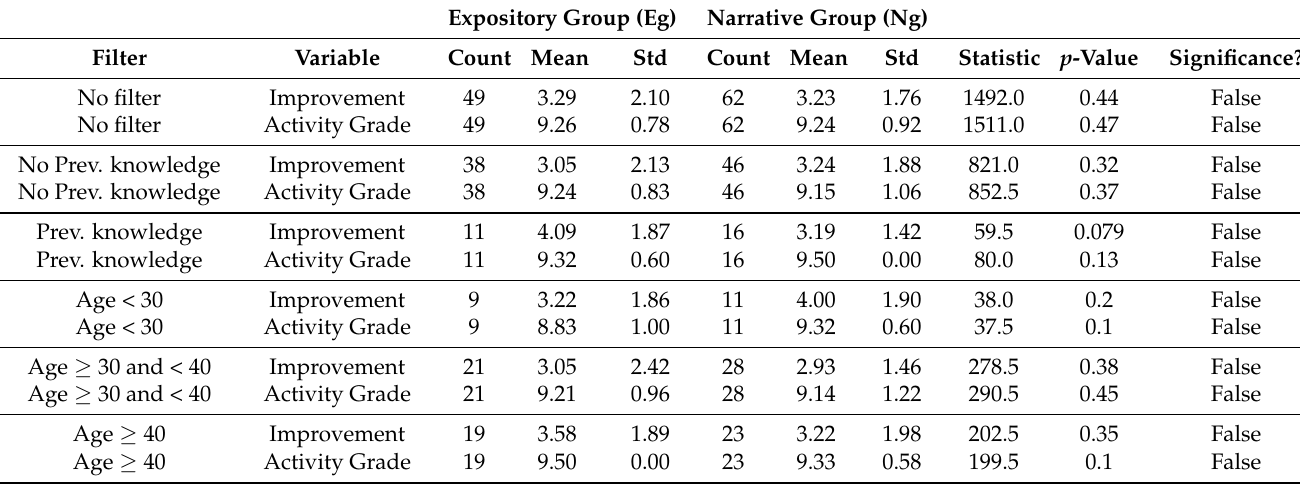
Table 4. Results of the Mann–Whitney U test of the variables related to knowledge